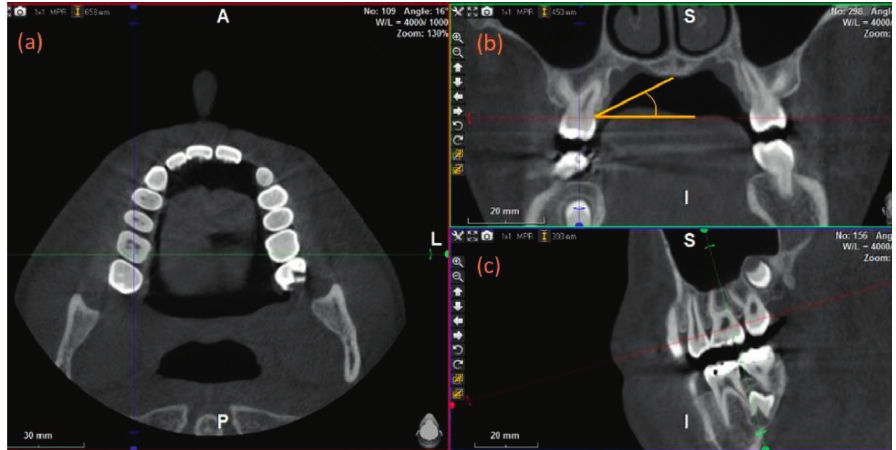
Figure 2: (a) A specific section on the midpalatal root of the maxillary first molar in the horizontal plane. (b) Palatal vault angle in the frontal plane. (c) A midsection of the palatal root in the sagittal plane.